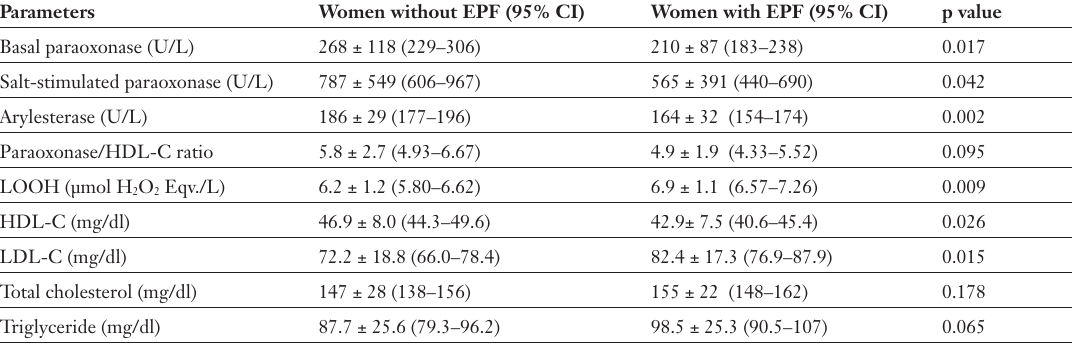
Lipid hydroperoxide level, PON/HDL ratio, basal/salt-stimulated paraoxonase/aryleste rase activities and clinical parameters in women with and without